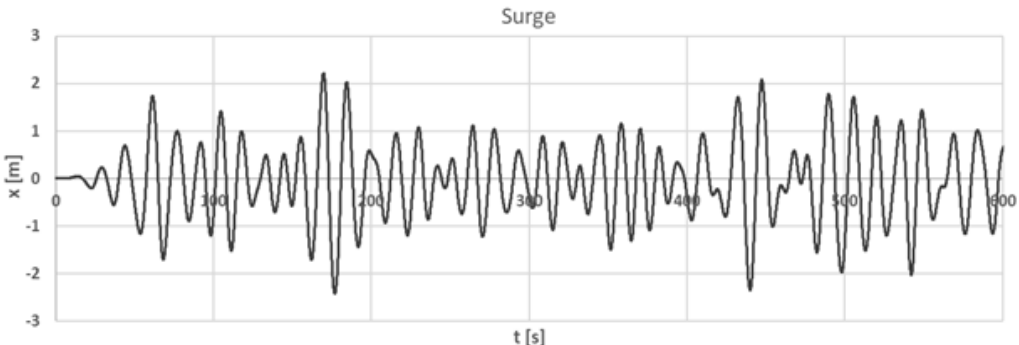
Figure 17. Surge response to IW8 according to the coupled time − domain solver SESAM DeepC ® .